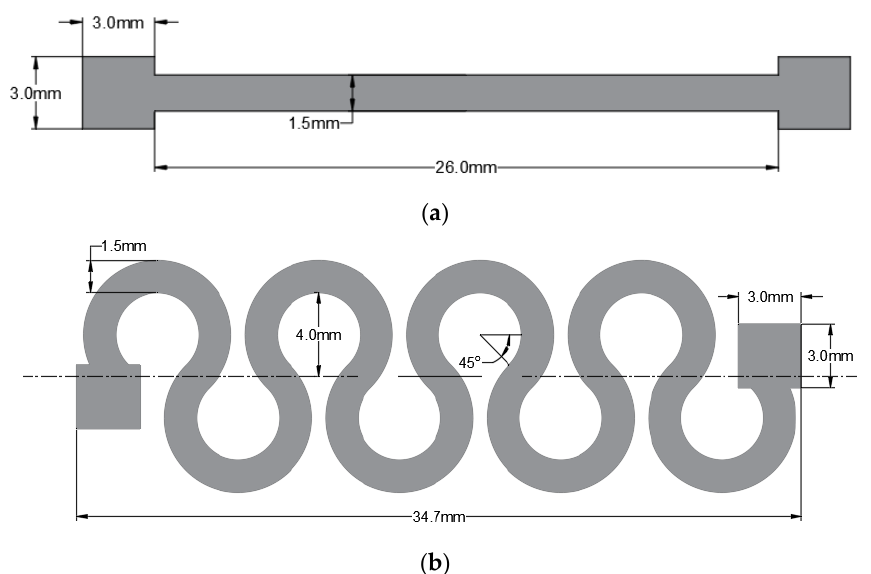
Figure 3. The shape and the dimensions of the examined patterns: ( a ) straight line, and ( b ) horseshoe.